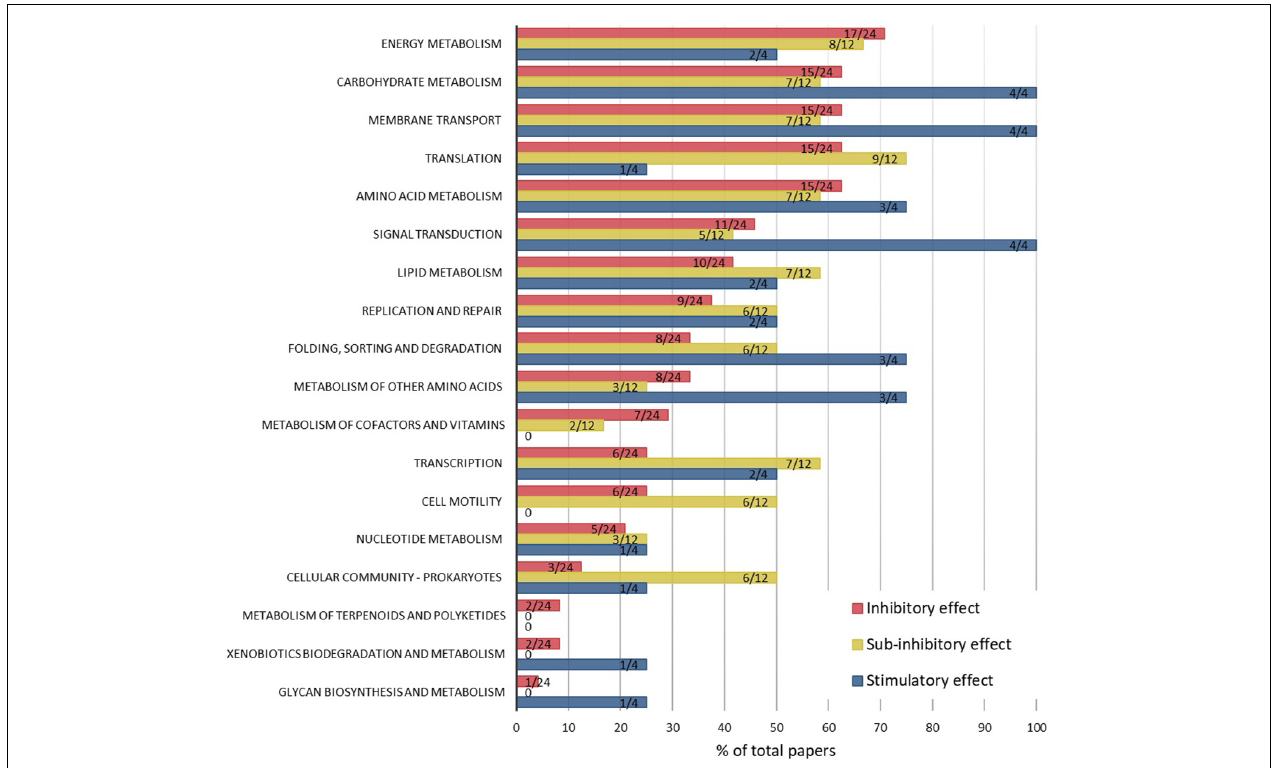
FIGURE 3 | Percentages of papers which report ENM-induced pathway modulations, by KEGG pathways and ENM effect levels, which were associated with inhibitory (24 papers), sub-inhibitory (12 papers), or stimulatory (4 papers) outcomes to the physiology (mainly growth or viability) of bacteria. The data labels indicate the number of papers reporting the affected pathway out of the total number of papers in each of the three categories. Raw data are summarized in Supplementary Table 2